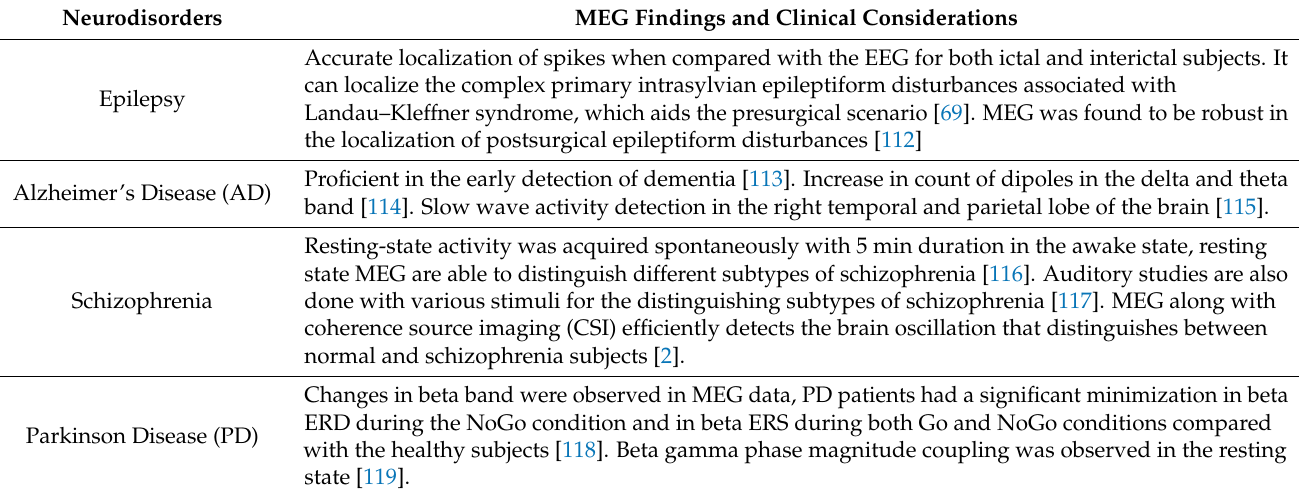
Table 2. MEG findings and Clinical